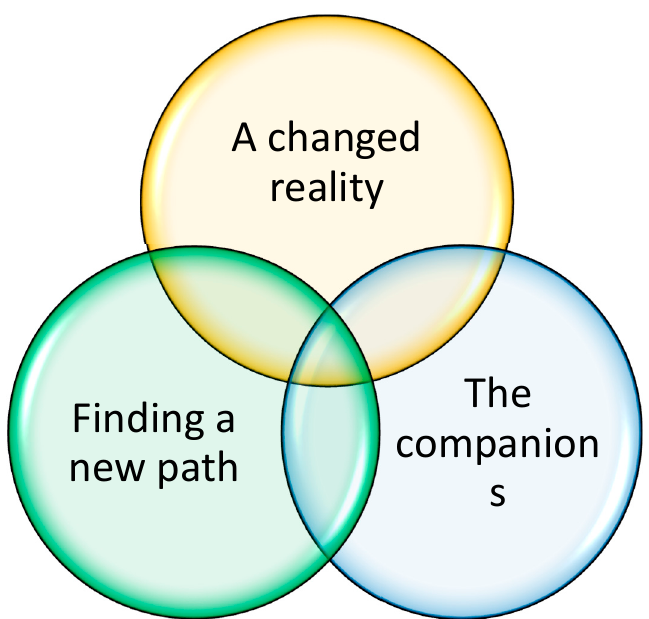
Figure 1. The over-all results of the inductive qualitative thematic analysis. Three interrelated themes describing the building blocks and process towards self-management of PD for persons affected and their care partners as described by participants of the Swedish National Parkinson School.